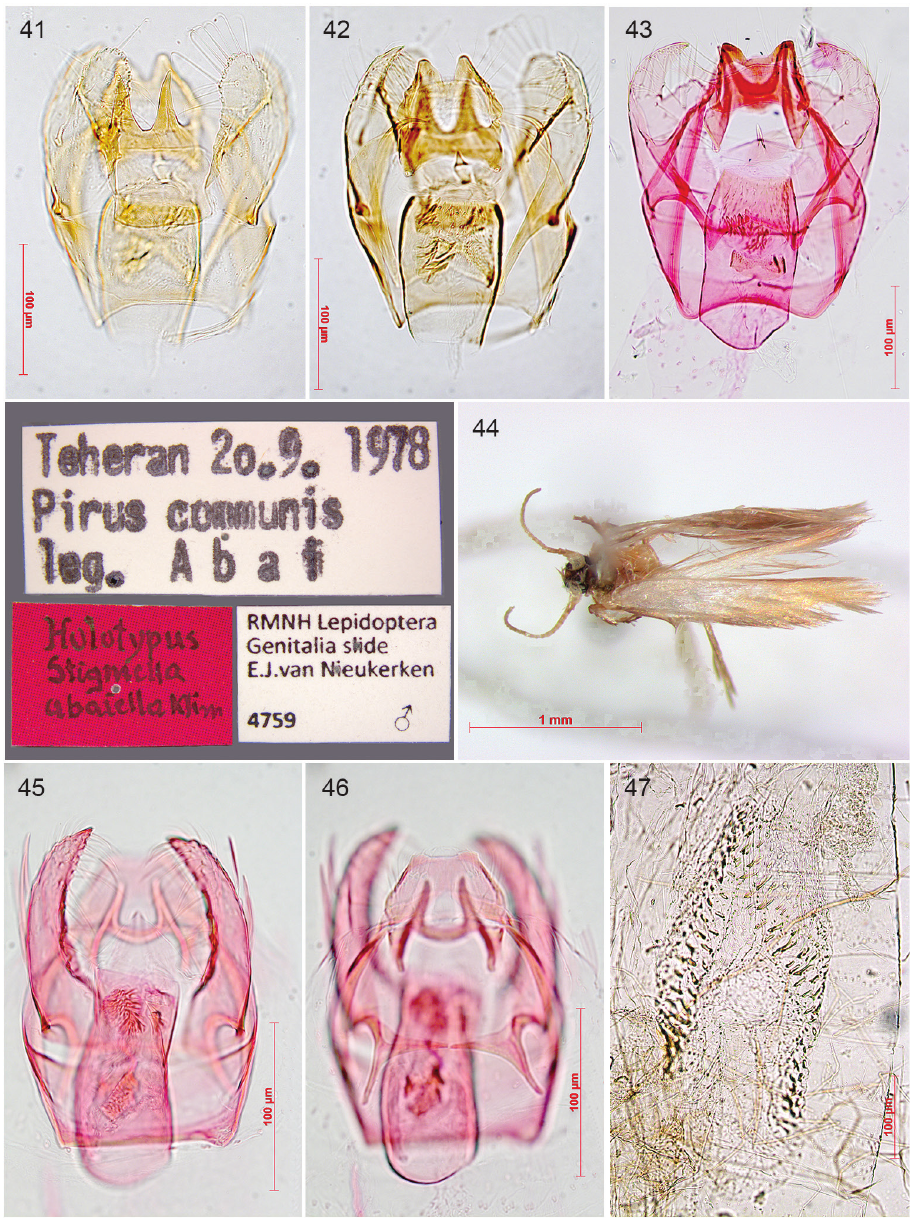
Figures 41–47. Stigmella species. 41–43 S. palionisi Puplesis, 1984 41, 42 Male genitalia of paratype of Stigmella nakamurai Kemperman & Wilkinson, Japan, slide VU 0790 43 Male genitalia of specimen from Russia, Primorye, slide JCK8111. 44–47 Stigmella abaiella Klimesch, 1979 44 Holotype male with labels 45, 46 Male genitalia of holotype, slide EvN4759 47 Female genitalia, paratype, slide Klimesch